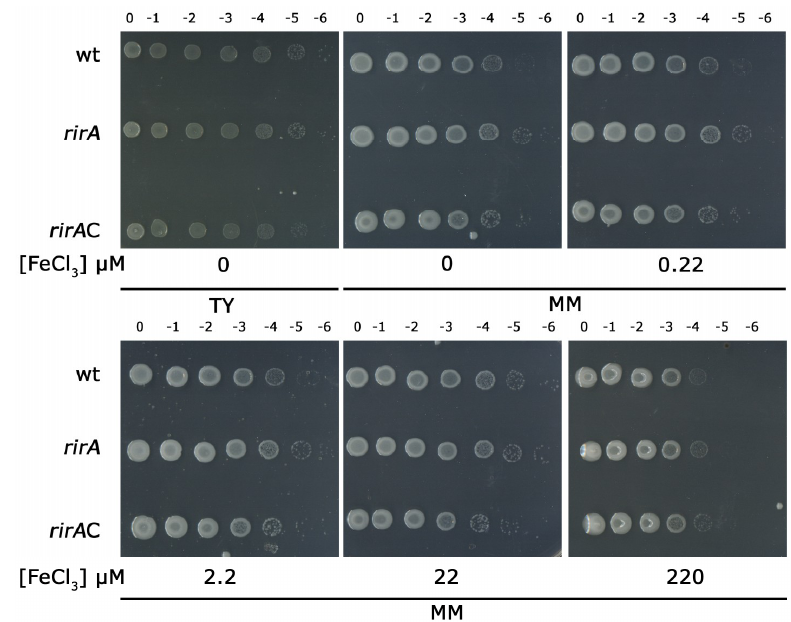
Figure 1. Growth of S. fredii wild-type strain SVQ269 (wt), rirA mutant SVQ780 ( rirA ) and complemented strain SVQ780C ( rirA C) on tryptone-yeast extract (TY) and minimal medium (MM) agar plates in the absence or presence of different concentrations of FeCl 3 as indicated. Tenfold serial dilutions of bacterial cultures (10 9 cells/mL) are marked above each column. A representative example of at least two experiments is shown.